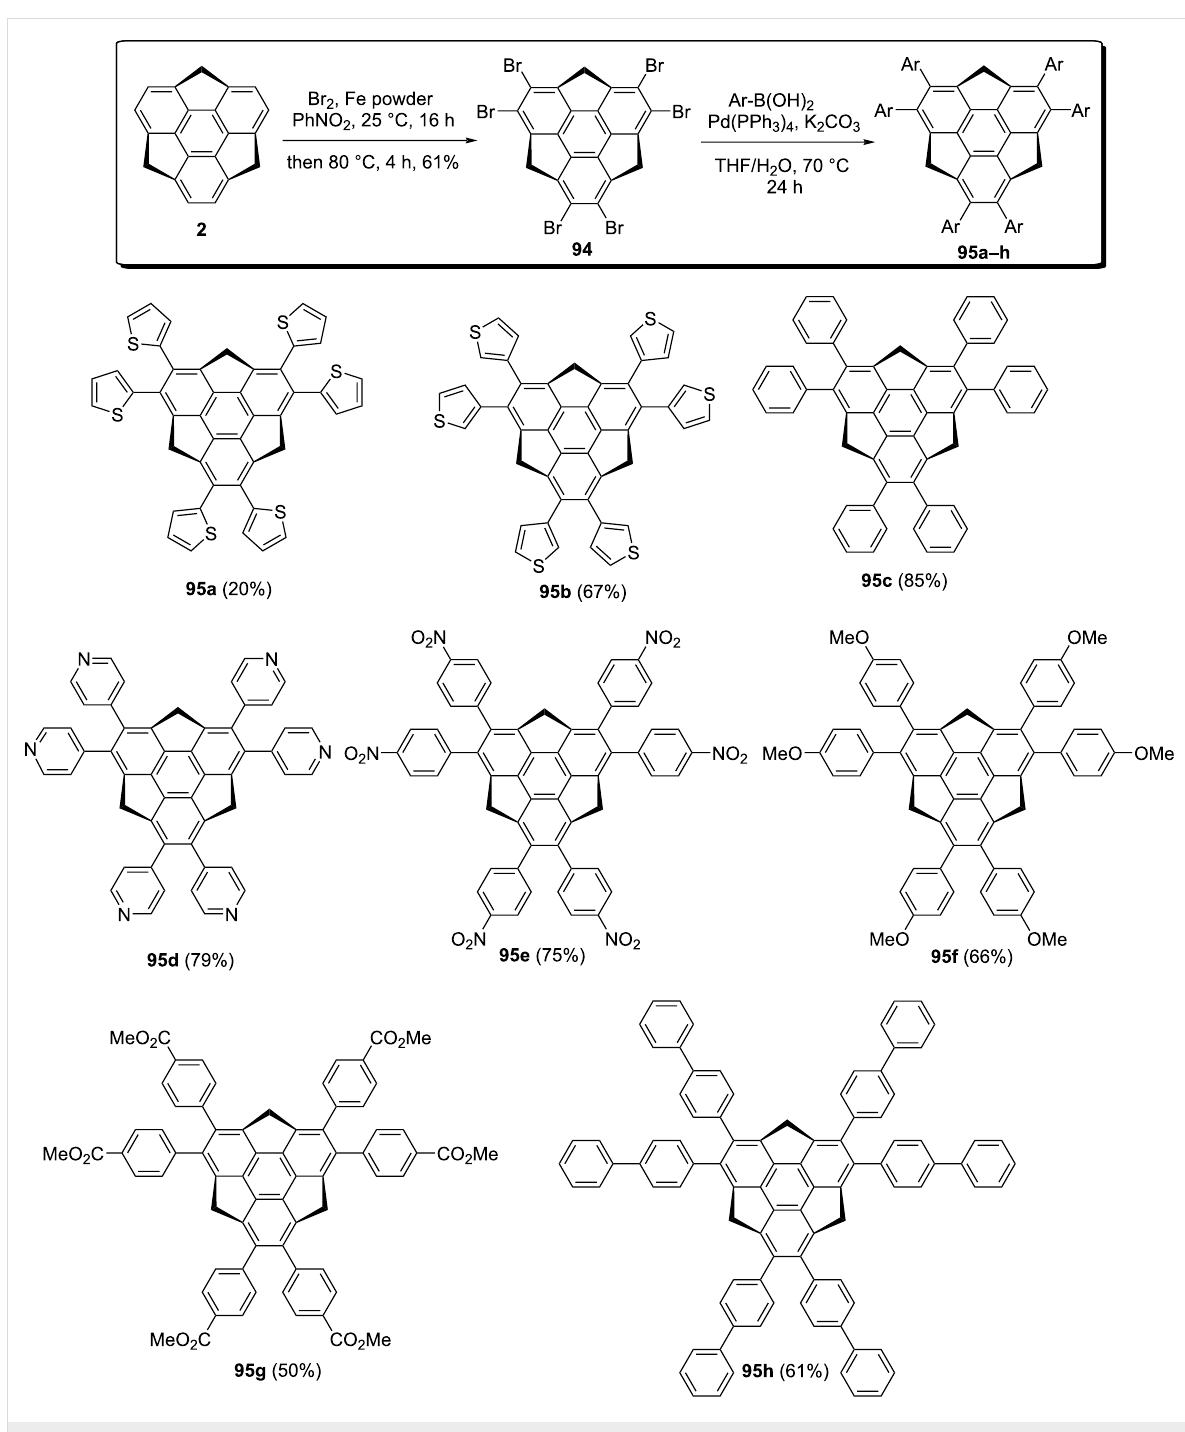
Scheme 23: Synthesis of various hexaarylsumanene derivatives using the Suzuki-coupling reaction.